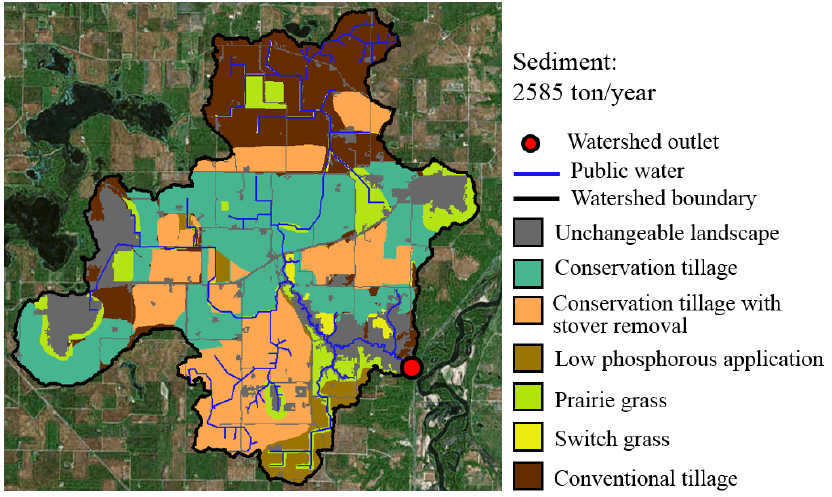
Figure 8. Stakeholder solution with collaborative